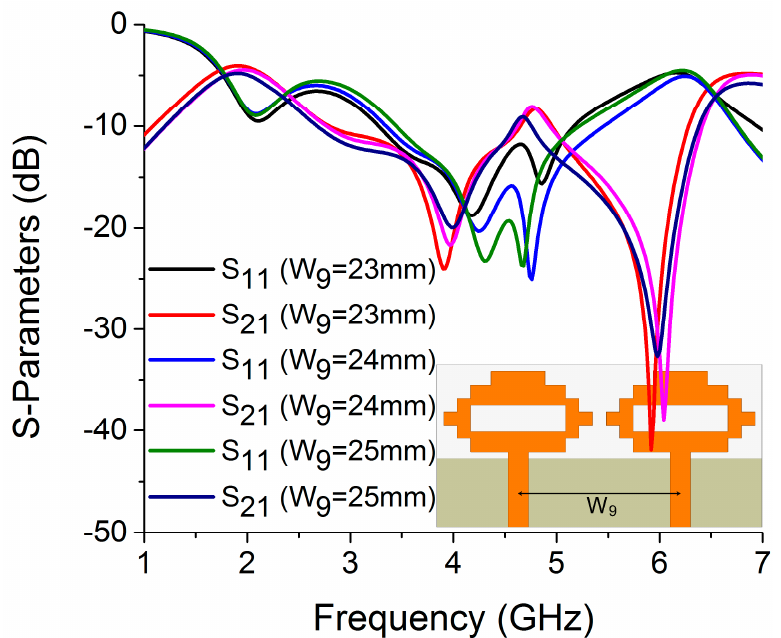
Figure 21. Influence of W 9 on S-parameters.